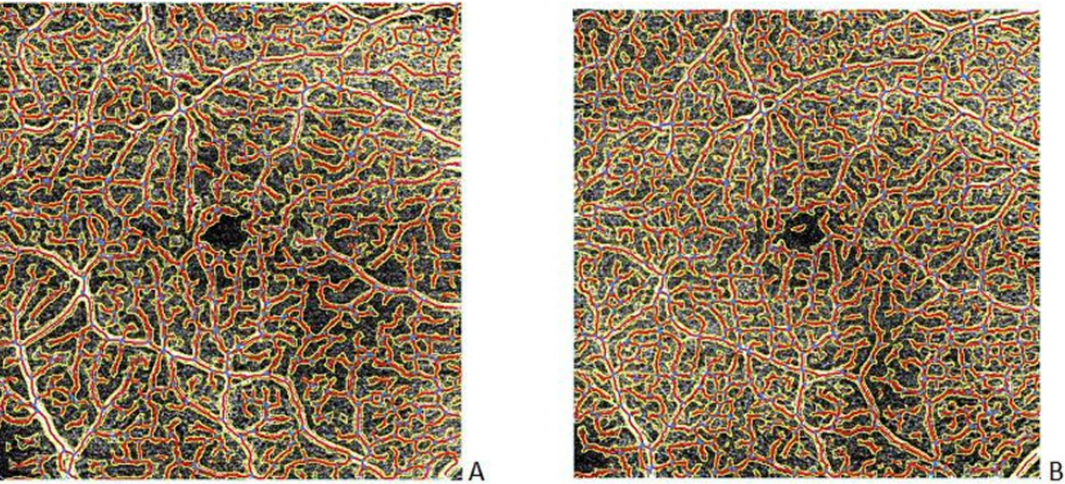
Figure 3. An example of vascular network of the SCP before ( A ) and after ( B ) treatment of bevacizumab intravitreal injections assessed with AngioTool software.